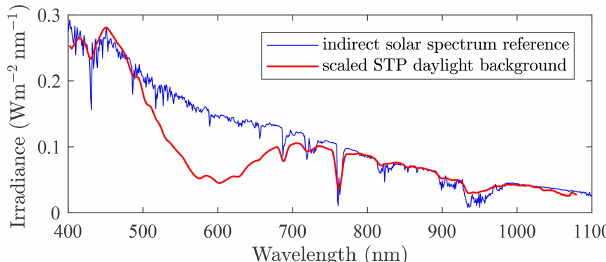
Figure 20. Daylight sky background: standard ASTM G173-03 indirect solar reference sky irradiance spectrum (blue); scaled starphotometer background measurements at Eureka (18 February 2018, 10:33LT, local time) to match the ASTM infrared level (red).